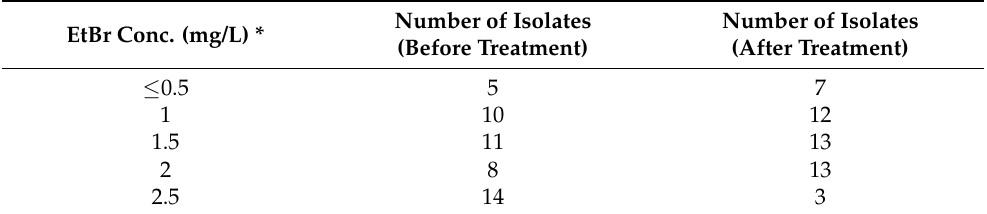
Table 2. Efflux activity of S. aureus isolates determined using EtBr cartwheel method, before and after treatment with AgNPs.